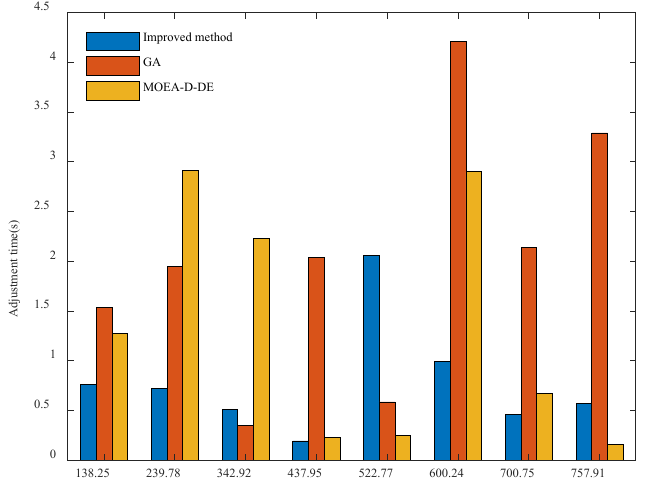
Figure 9. Comparison of the adjustment times.